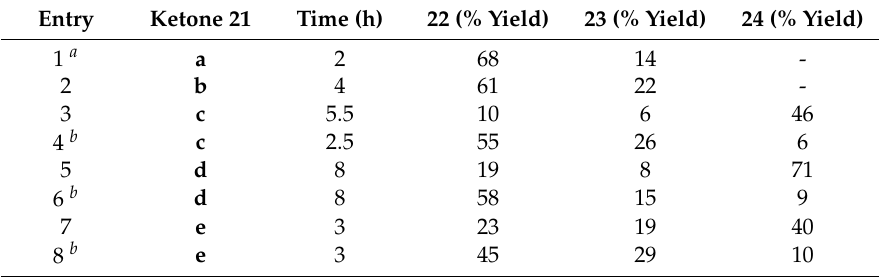
Table 2. Yields of the products obtained in the reaction of β -CHOTPP 3 with ketones 21 . Entry Ketone 21 Time